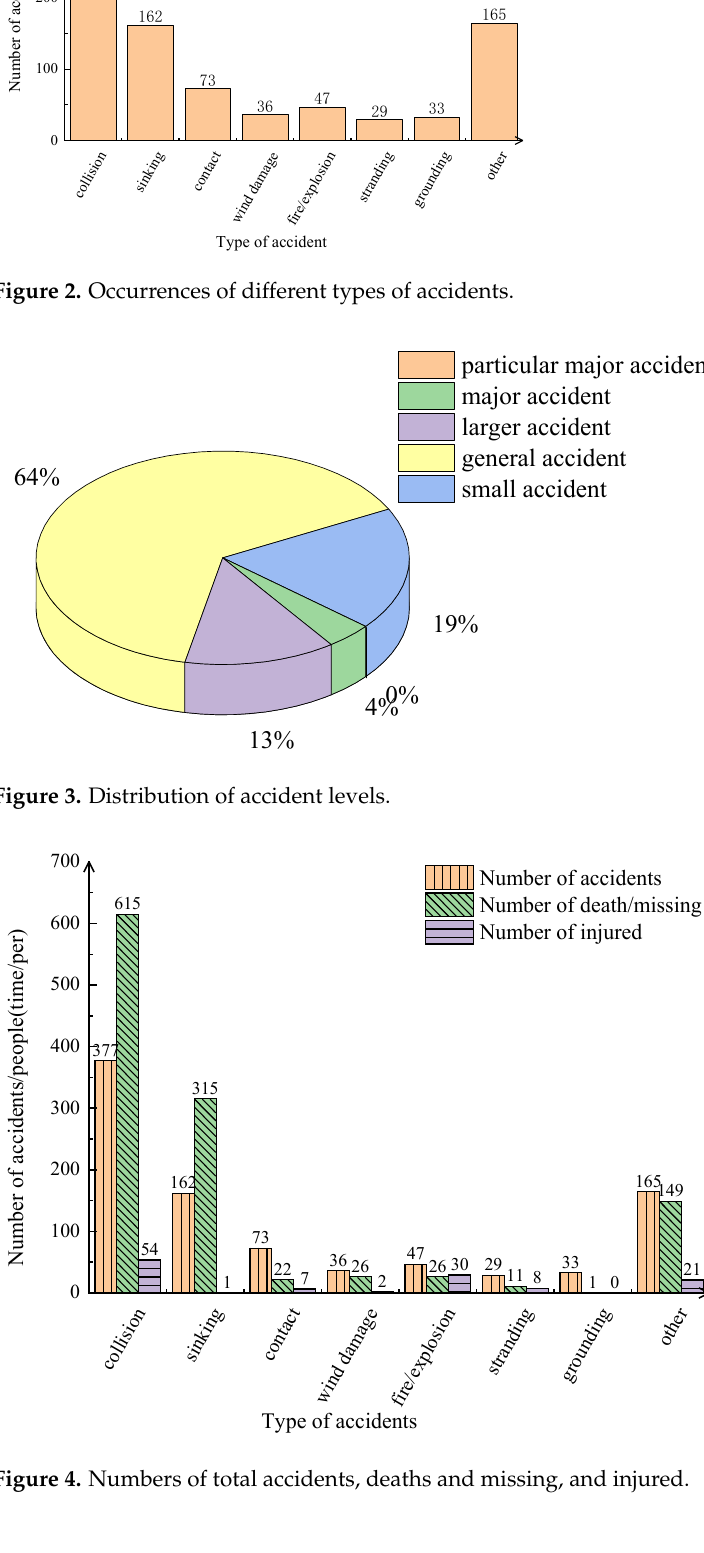
Figure 2. Occurrences of different types of accidents.